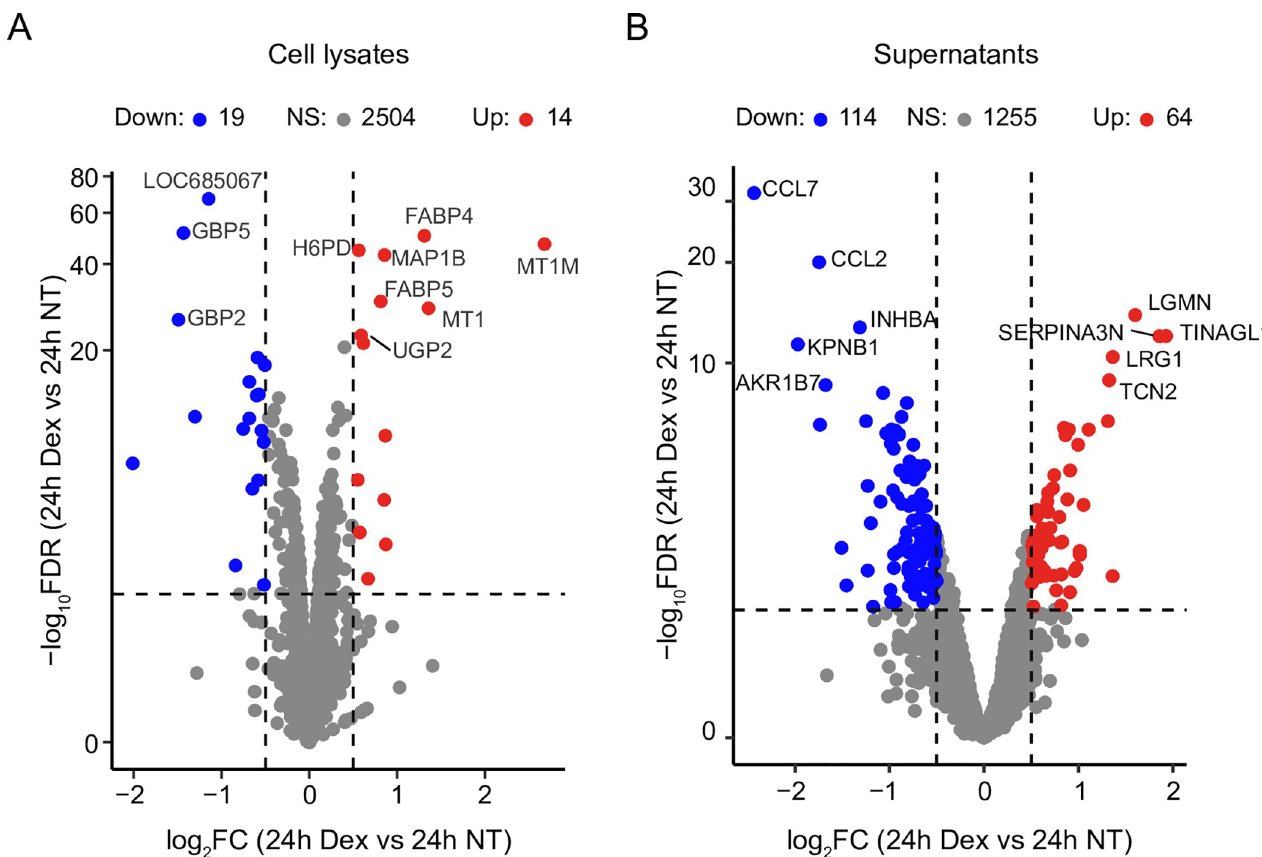
Fig 4. Comparison of the proteomes of cell lysates and supernatants of 24 h LSEC cultures incubated with or without Dex. Volcano plots illustrating differently expressed proteins in (A) the LSEC cell-associated proteome at 24 h ± Dex, and (B) the LSEC supernatants ± Dex. The Top 10 differentiated proteins are illustrated with symbols. Significance level: FDR � 0.05, and |log 2 FC| � 0.5. NS, not significant.